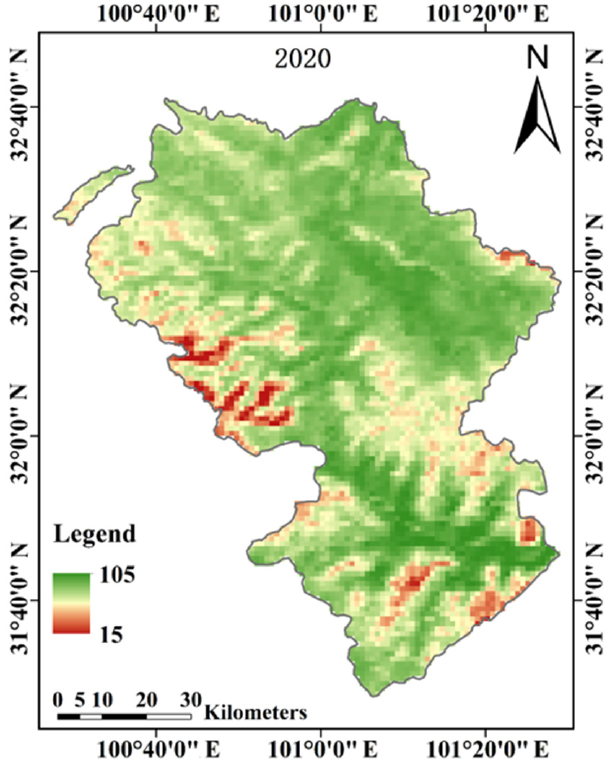
Figure 8. Vegetation cover index of Rangtang County.